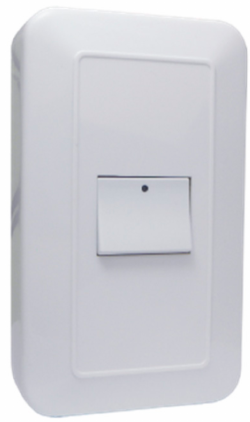
Figure 19. Lighting delay